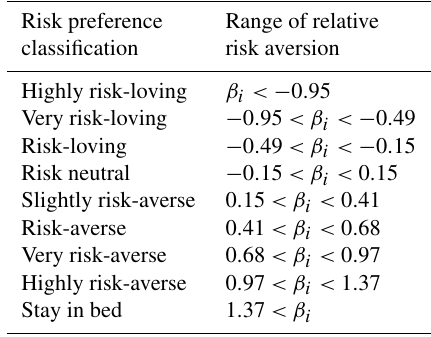
Table A1. Risk preference scale depending on the parameter β i , according to Holt and Laury